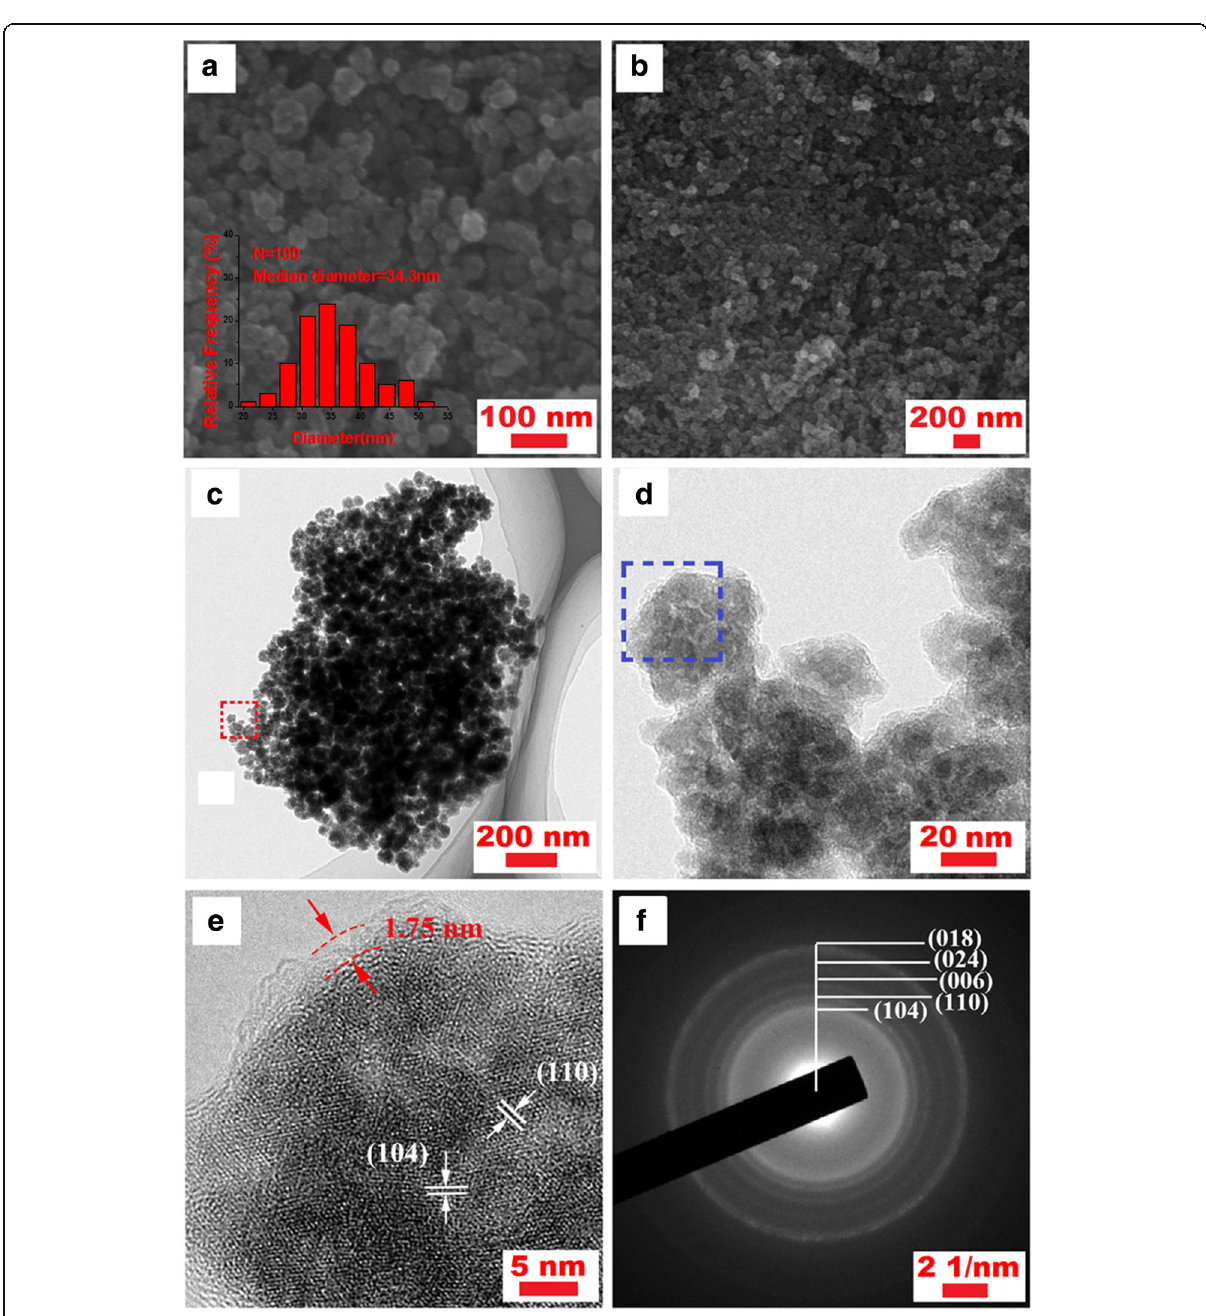
Fig. 3 a , b SEM images of Fe 2 O 3 /C nano-composite; insets: the pore size distribution of Fe 2 O 3 /C composites. c , d TEM images of Fe 2 O 3 /C nano- composite. e High-resolution TEM image and f corresponding SAED patterns of Fe 2 O 3